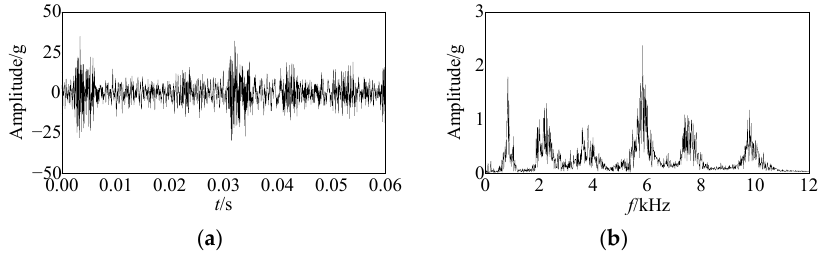
Figure 10. Reconstructed vibration signals under Condition 1: ( a ) time domain; ( b ) frequency domain. To explain the advantages of VMD, the complete ensemble empirical mode decomposition with adaptive noise (CEEMDAN) was employed to decompose the measured signal; the results are shown in Figure 11. There were 11 IMFs in the results of the CEEMDAN; only the first 7 IMFs are shown, as the rest were obvious illusive